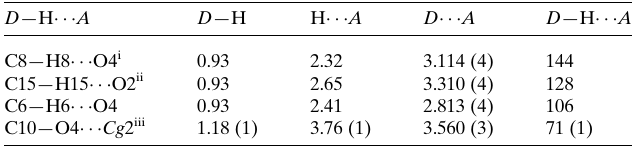
Table 1 Hydrogen-bond geometry (A˚ , (cid:3) ). Cg 2 is the centroid of the C4–C9 ring.